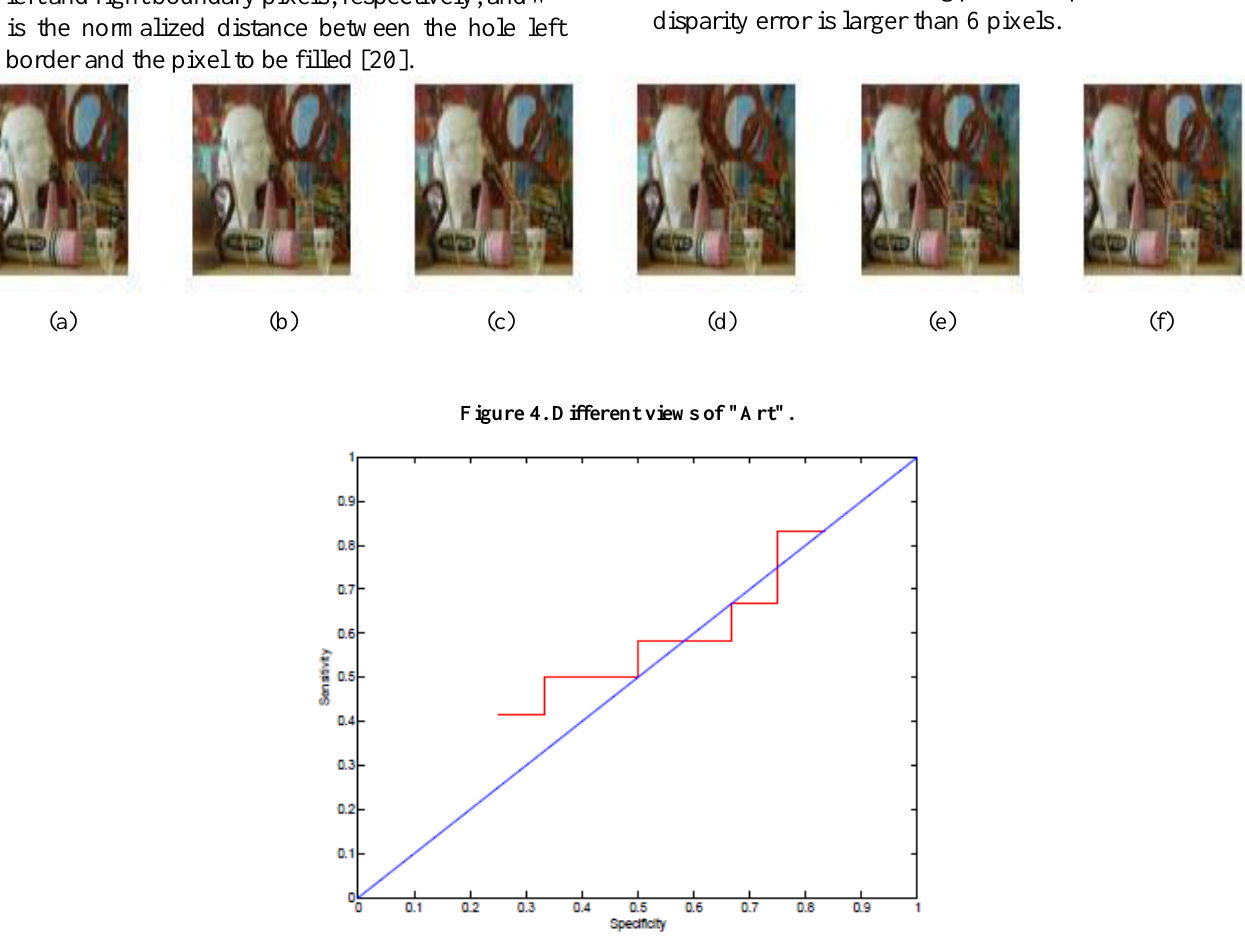
Figure 5. ROC curve for "Art" considering different thresholds of